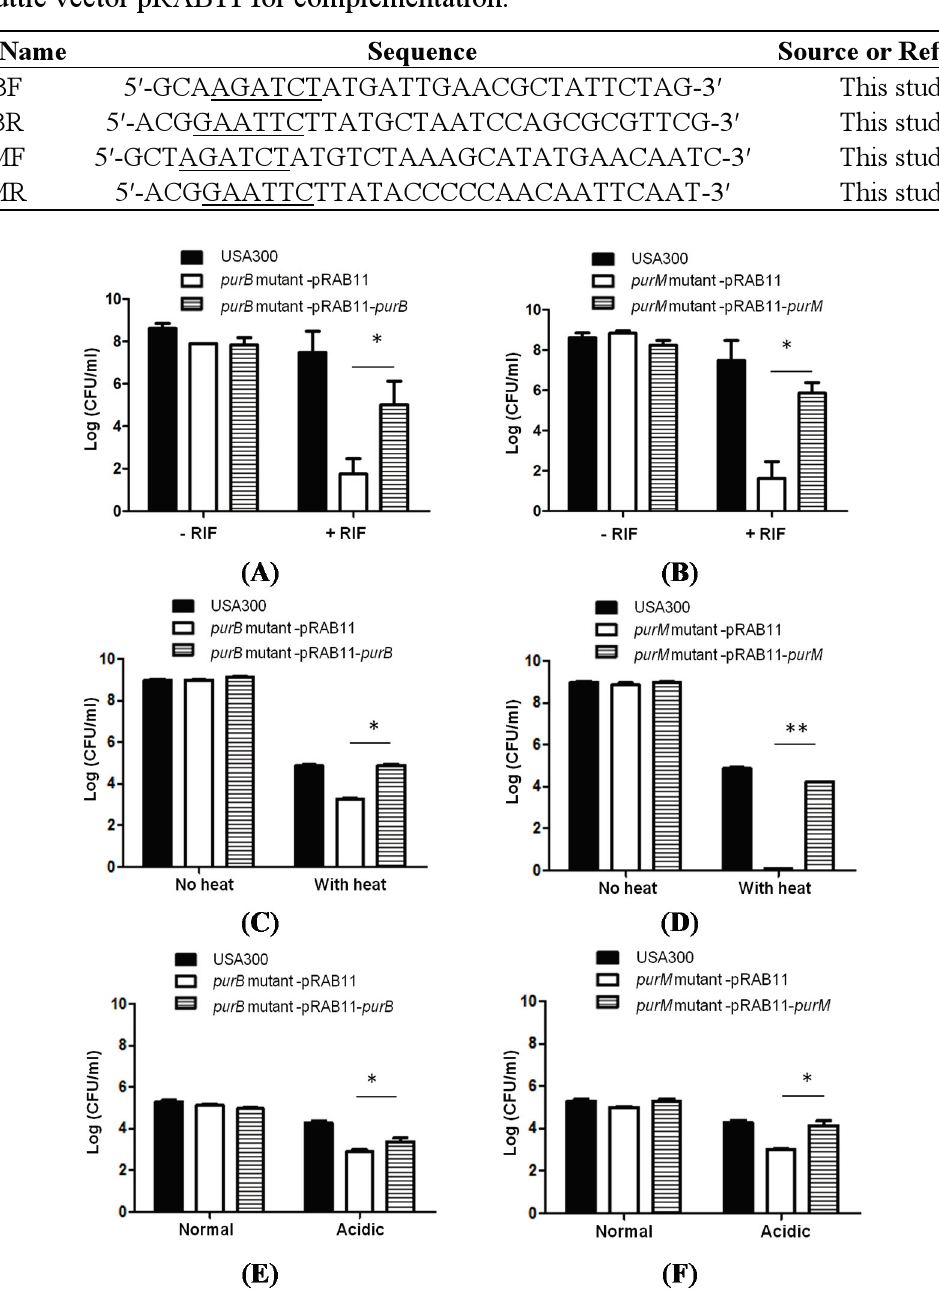
Figure 4. Restoration of persistence phenotype in complemented mutants. Survival of stationary phase cultures of S. aureus purB and purM mutants transformed with vector pRAB11 or pRAB11-wildtype purB and purM and the parent strain USA300 upon ( A , B ) rifampicin exposure (2 μ g/mL, >10× MIC) at 5 days post-exposure; ( C , D ) heat exposure (58 °C for 40 min) and ( E , F ) low pH of 4.0 for 9 h. The S. aureus purB and purM mutants complemented by their corresponding wildtype genes partially restored the persistence phenotype of the mutants (Student t -test, * p -value < 0.05, ** p -value < 0.005). No change in persistence was observed in stress-free conditions over the course of 5